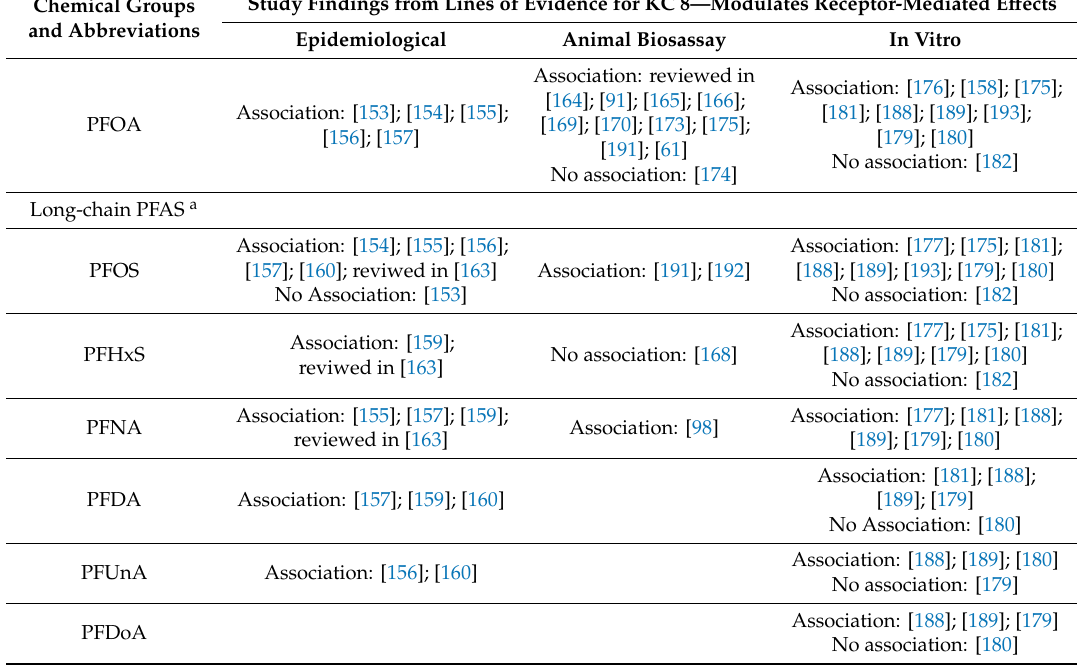
Table 7. Chemical specific study findings for key characteristic eight—modulates receptor-mediated e ff